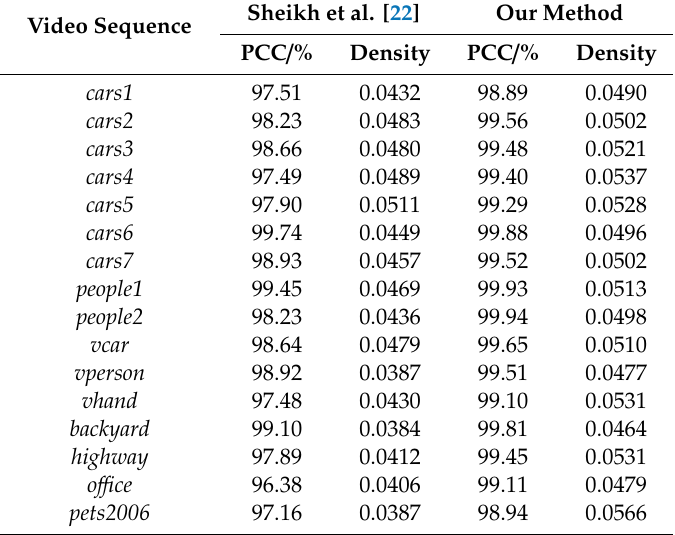
Table 1. Quantitative evaluation of motion trajectory